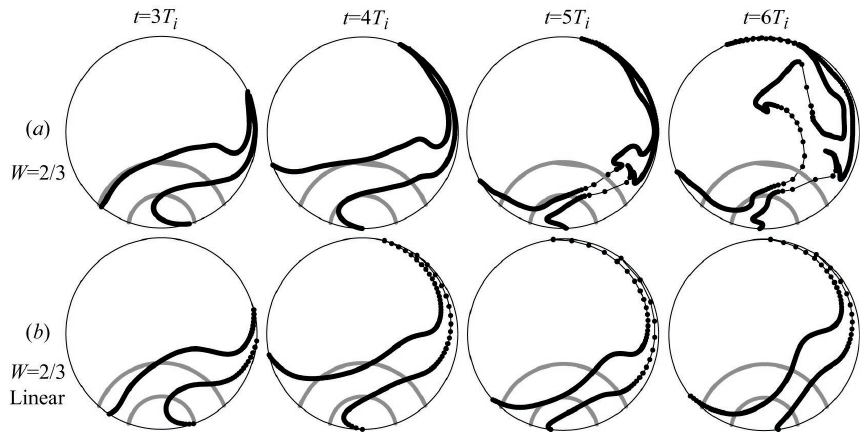
Fig. 10. Evolution of a particle cloud for B = 3 with the Wedderburn number W = 2 / 3. Row (a) is subject to nonlinear flow for the lowest vertical mode and linear hydrostatic flow for the second vertical mode. Row (b) is subject to linear hydrostatic flow for both vertical mode-one and two. Grayed points represent the initial position of particles. ( h 2 = 1, h 3 =